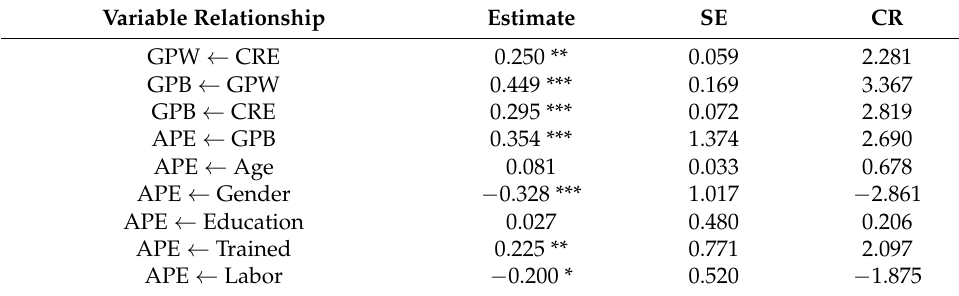
Table 7. Estimation results for the standardized path coefficients.